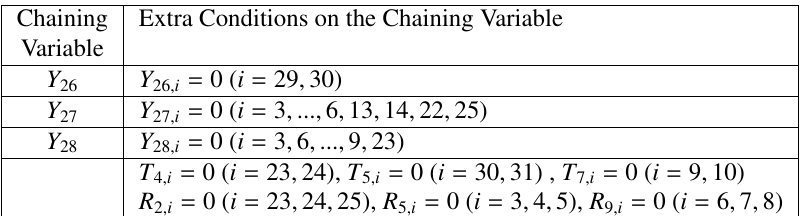
Table 11: The Extra Conditions of the Generalized Message Modification in the Right Branch